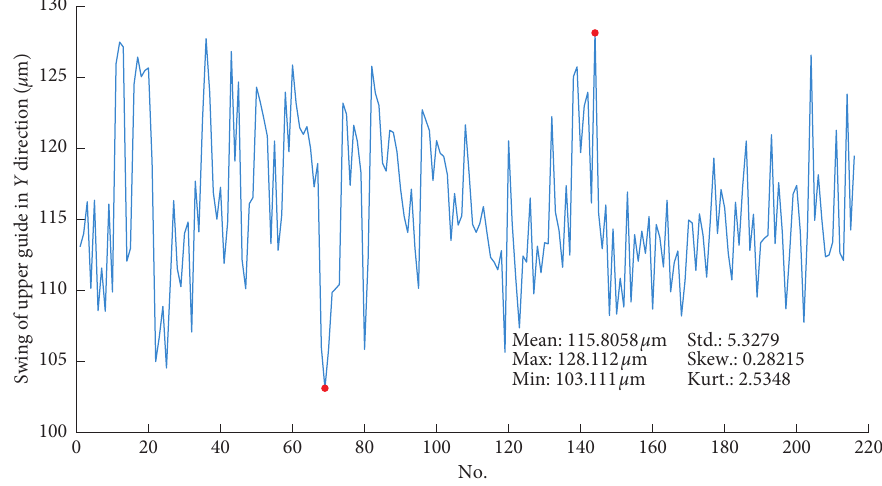
Figure 7: The swing data of upper guide in Y direction. Table 3: Optimal parameters corresponding to each forecasting component for the proposed model. Parameters